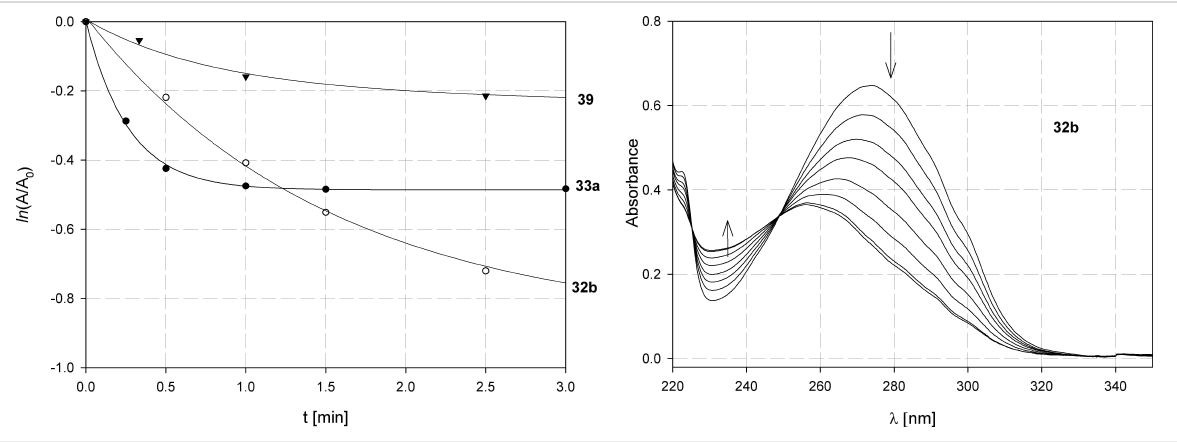
Figure 8: Comparison of photochemical reactivity of 32b , 33a , 39 (left). Irradiation UV spectrum of 32b in ACN (right, t = 0, 0.5, 1, 1.5, 2.5, 4, 8, 16 min).